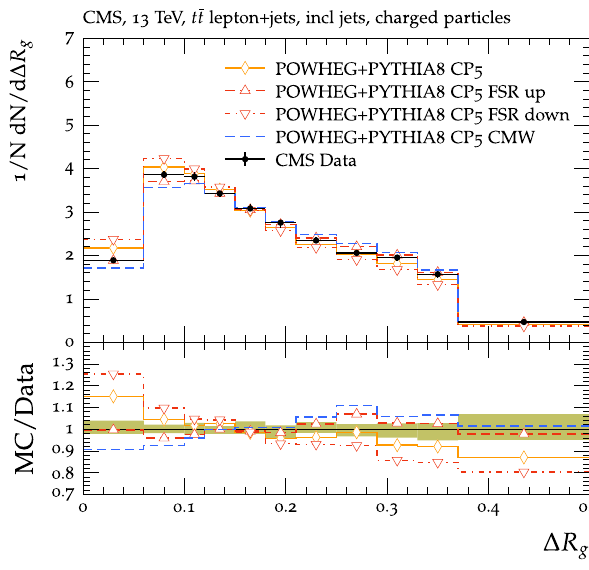
Fig. 20 Comparison with the measurement [70] of the angle between twogroomedsubjets, Δ R g intt eventspredictedby powheg + pythia 8 for the different tunes. The data are compared to tunes CUETP8M1, CP2, CP4, and CP5 (left). Tunes CP1 and CP3 are not displayed but they present a similar behavior as tunes CP2 and CP4, respectively. The data are also compared to CP5, CP5 FSR up, CP5 FSR down,